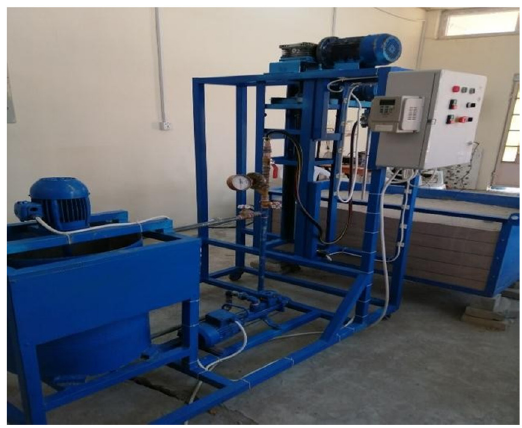
Plate 1: Side view of the low - pressure injection laboratory